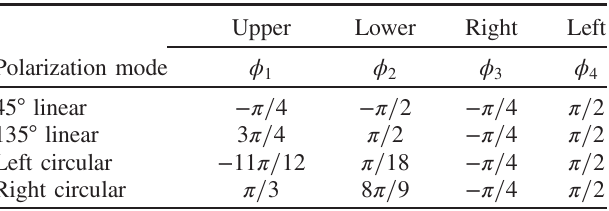
TABLE II. Phase shifts of magnet arrays for different polari- zation modes in the Knot AMPU.